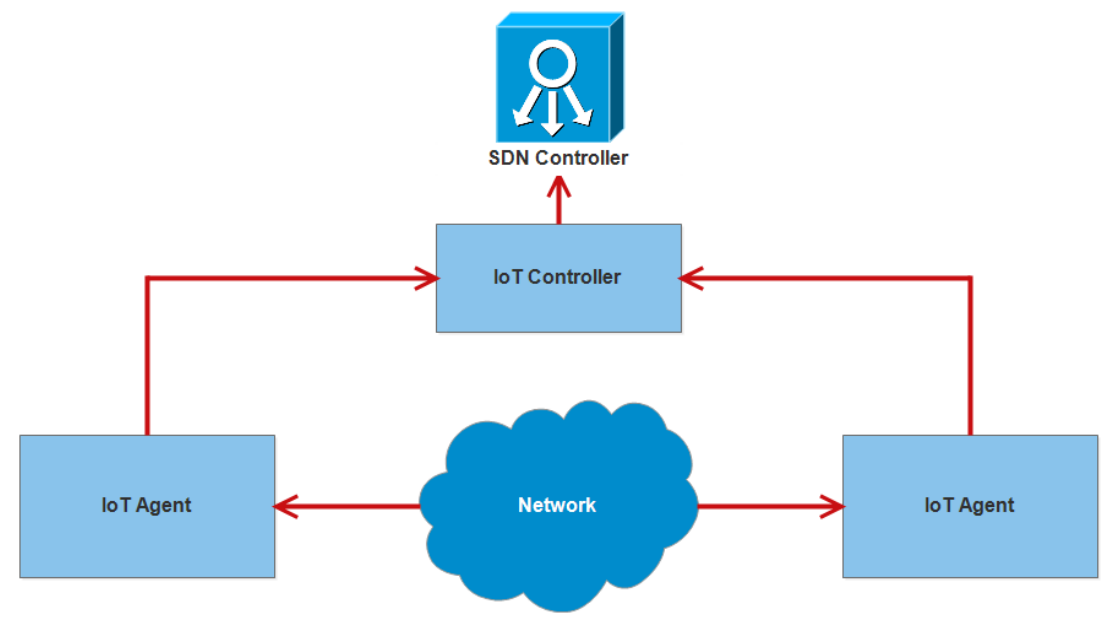
Figure 14. Association of SDN with IoT as a security